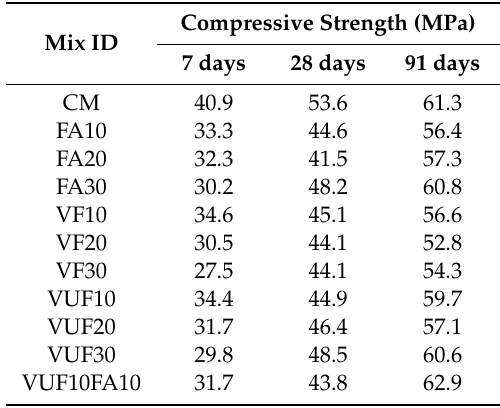
Table 4. Compressive strength of mortars with respect to